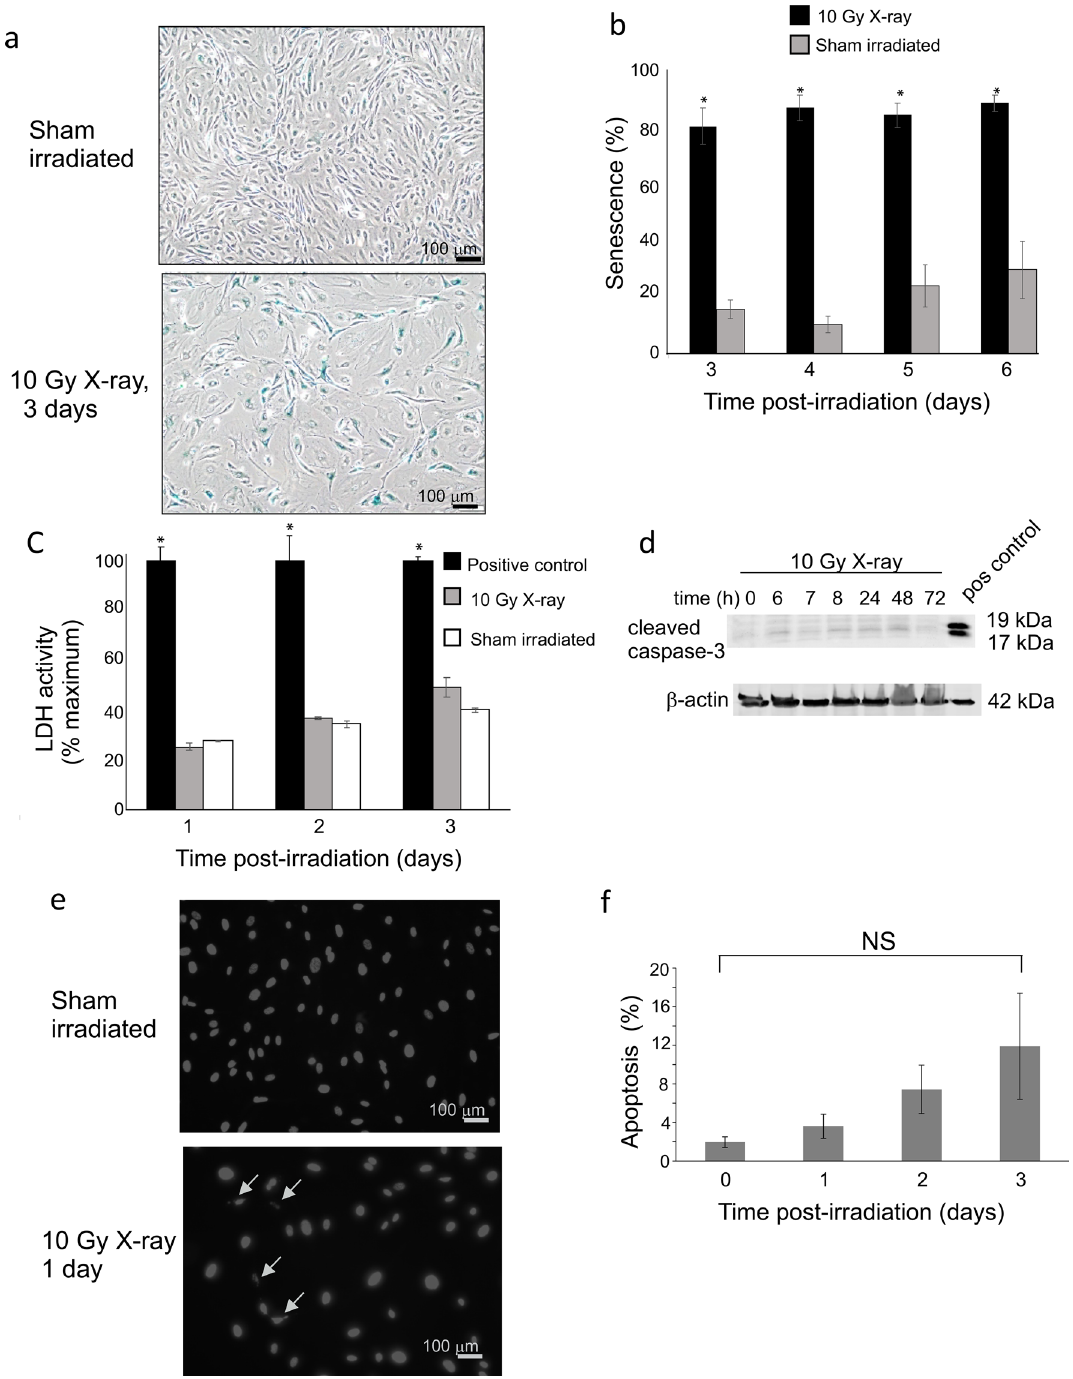
Figure 1. 10 Gy X-irradiation induces accelerated senescence, but not necrosis or apoptosis in HMLVEC. HLMVEC were grown to 70% confluence and sham irradiated or X-irradiated at 10 Gy. ( a ) Cells were stained for SA-β-gal activity at indicated times post-irradiation, and scored for SA-β-gal staining and senescent morphology. Representative images of SA-β-gal staining and cell morphology in control and irradiated HMLVEC. ( b ) All cells were counted in three random fields per dish (minimum 100 cells per field). The graph indicates means ± SE n = 6; * p < 0.05 from sham irradiated. ( c ) LDH released into the medium was measured at 24, 48, and 72 h post-irradiation. Cell death by necrosis is expressed as a percentage of LDH in the medium of irradiated or sham irradiated cells divided by the LDH released in medium of positive control treated cells. Bars indicate mean ± standard error, n = 3. * p < 0.05 from sham irradiated. ( d ) HLMVEC were grown to 70% confluence and X-irradiated at 10 Gy. Cell lysates were prepared at the indicated time points, and western blots were performed for cleaved caspase 3 as an indication of apoptotic signaling. A positive control is provided for cleaved caspase 3 (pos control). ( e ) Cells stained with DAPI to visualize nuclear morphology to identify apoptotic nuclei. ( f ) Nuclei were scored from random fields to determine percentage of apoptotic nuclei; graph shows average of percent apoptosis ± SEM; NS = not